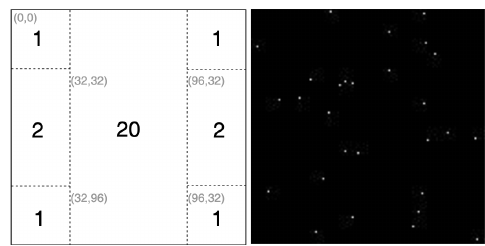
Figure 13. Hint mask for Colorization FID score evaluation. Table 2. Quantitative comparison of Colorization FID score. The score measured using total of 145,408 XDoG line-arts and 530 pairs of line-arts and their colorized version of artwork. Lower Colorization FID score is better. W/O Color